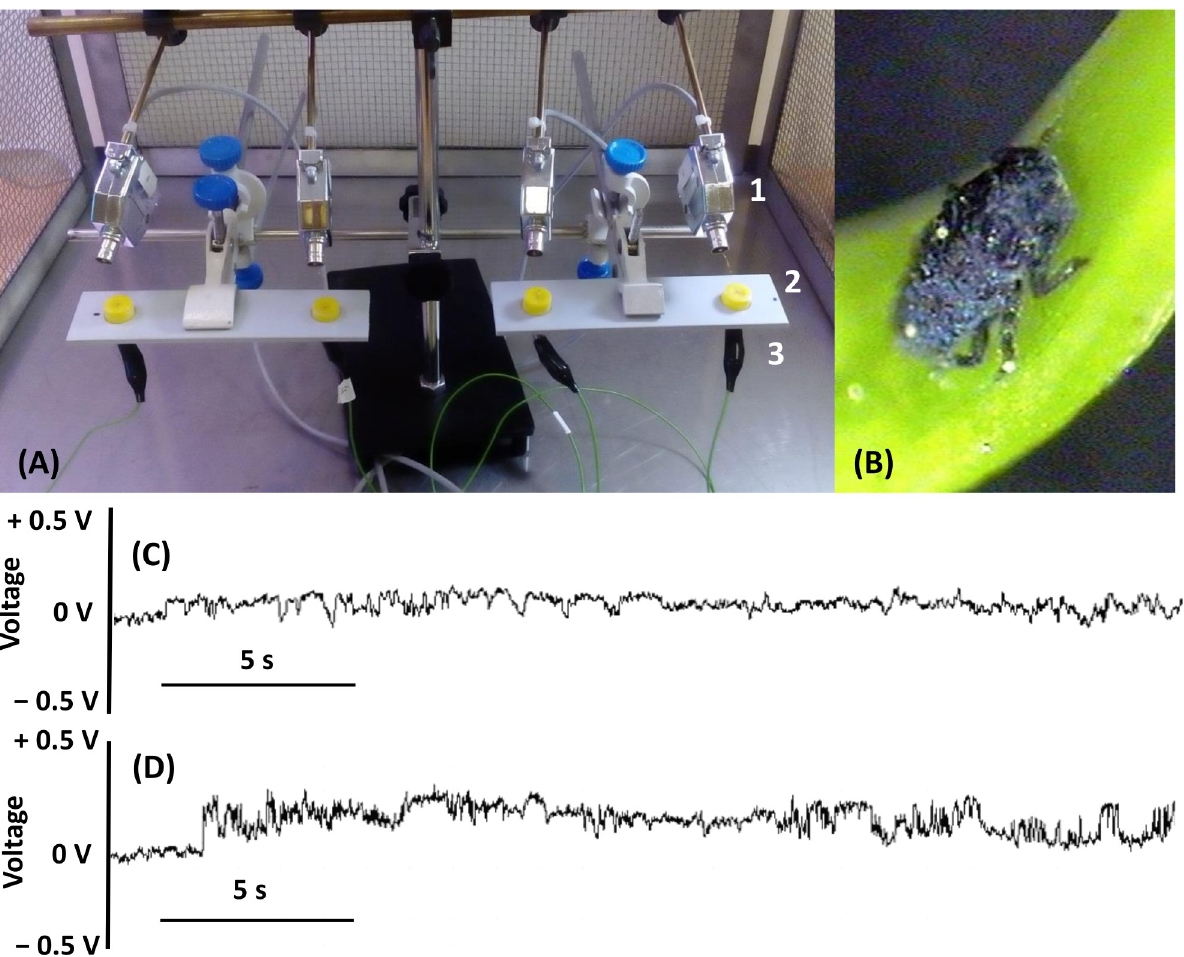
Fig 6. Waveform patterns AC-d generated by Adelges laricis on sucrose diets. (A) Equipment for EPG registration on sucrose diets, 1 –aphid electrode, 2 –diet chamber, 3 –diet electrode; (B) the mobile crawler of A . laricis (C)–(D) representative traces of waveform AC-d; 30 s traces, resolution